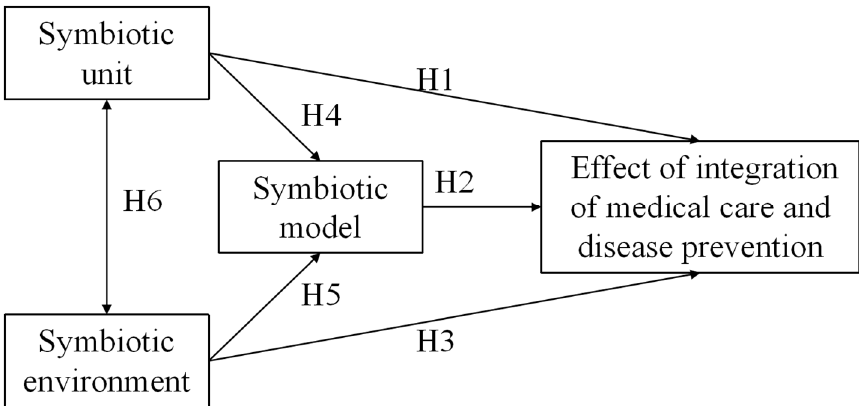
Figure 1. Integration of medical care and disease prevention model into a public hospital system.